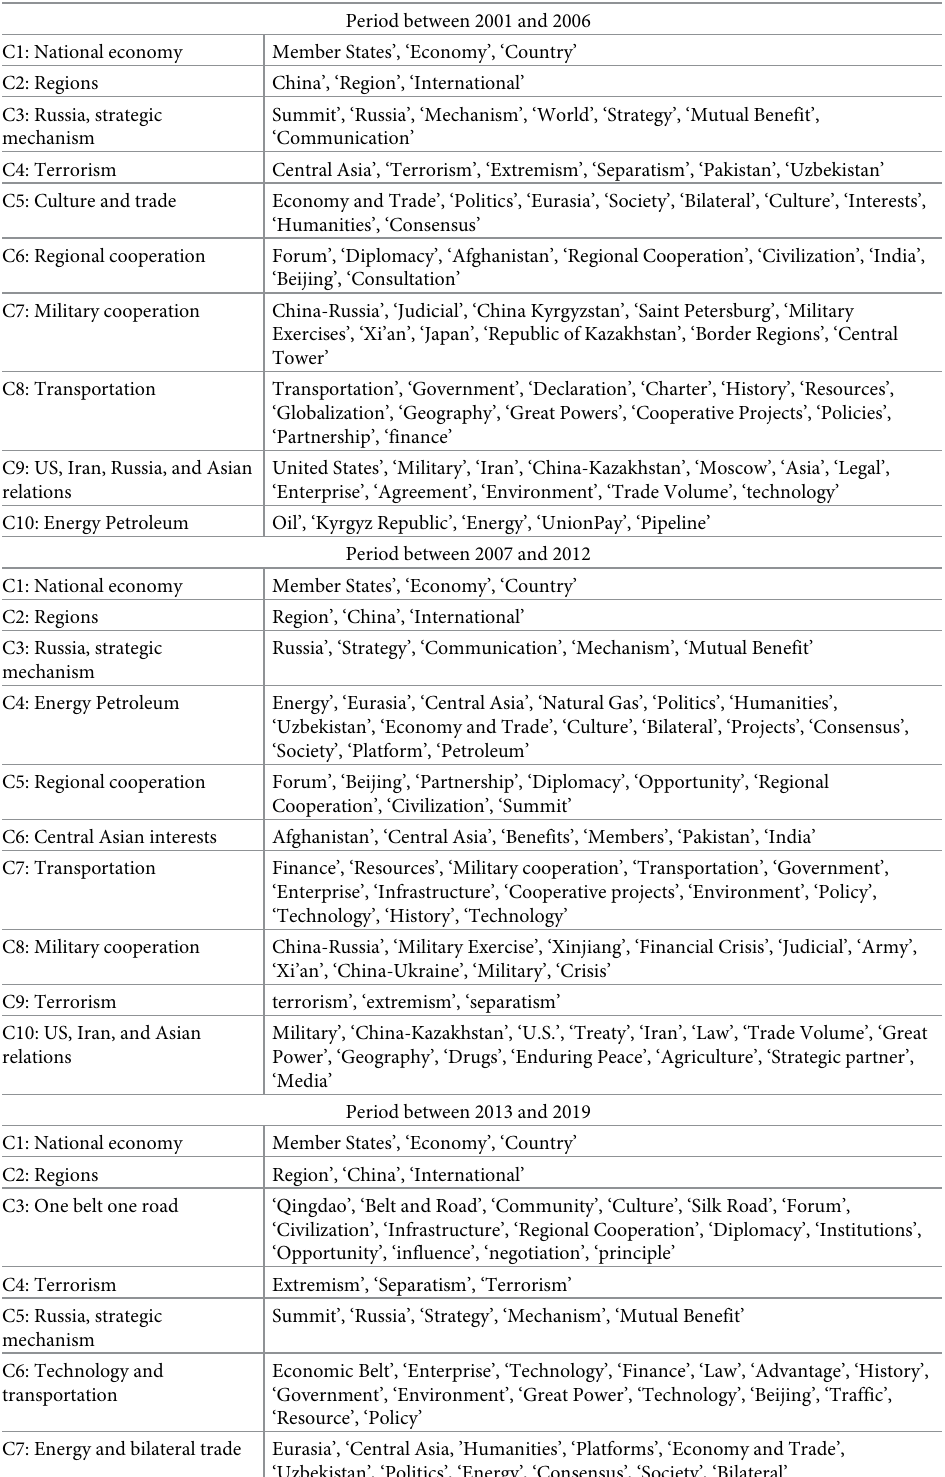
Table 5. The results of cluster analysis in three